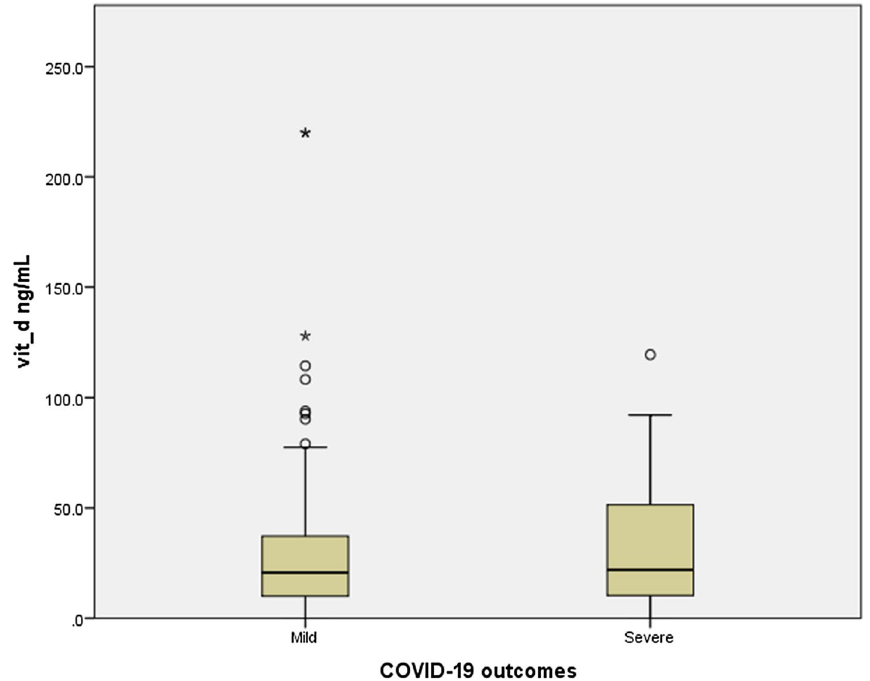
Figure 1. Mean 25-hydroxyvitamin-D levels in mild and severe